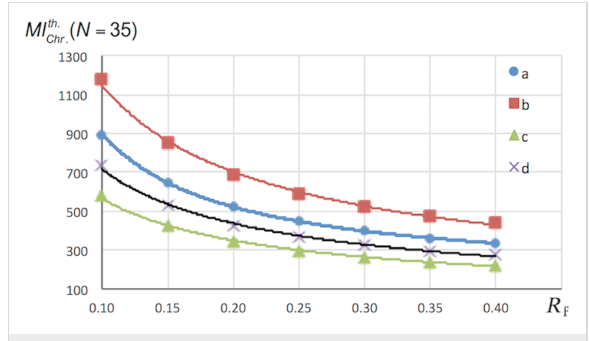
Figure 4: Variation of ( N = 35) with R f for the reactions of Scheme